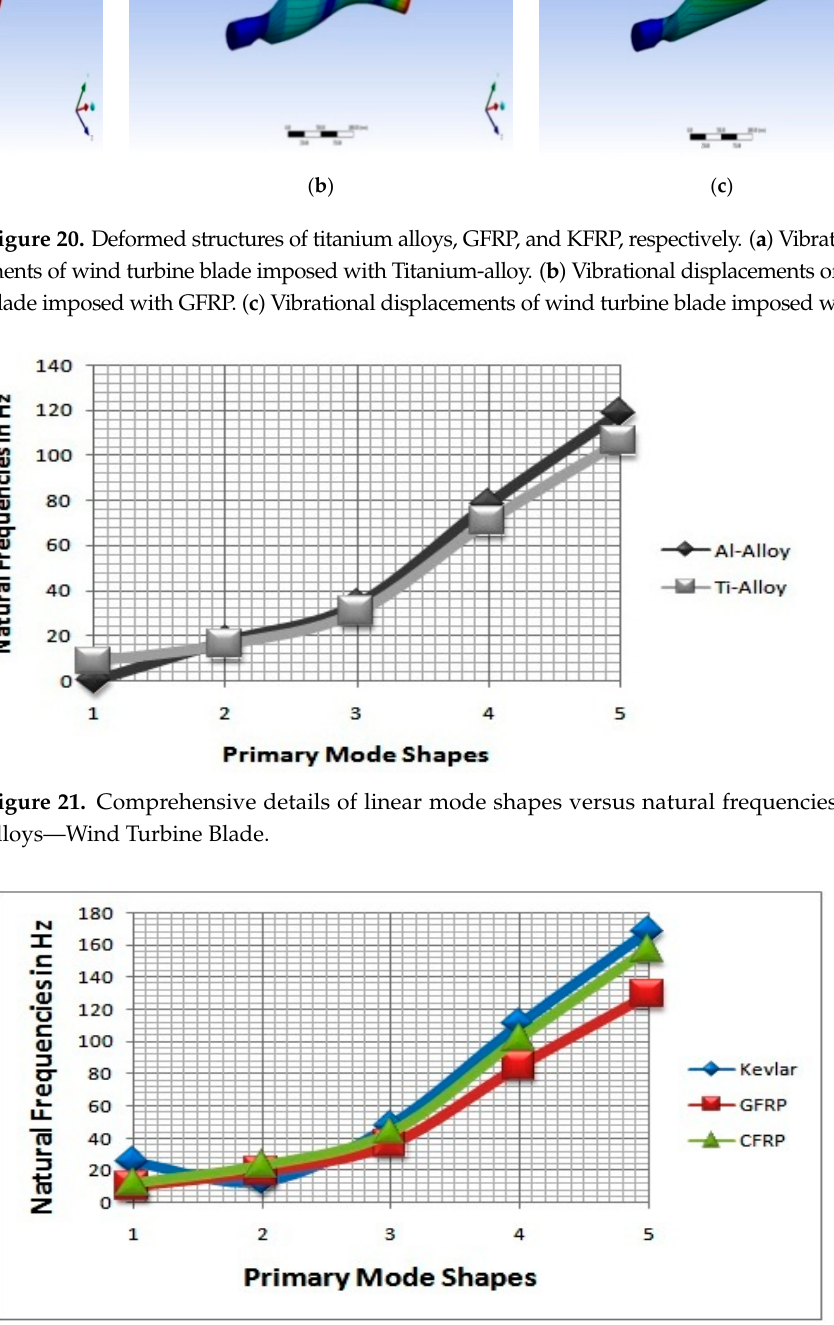
Figure 22. Comprehensive details of linear mode shapes versus natural frequencies for different composites—Wind Turbine